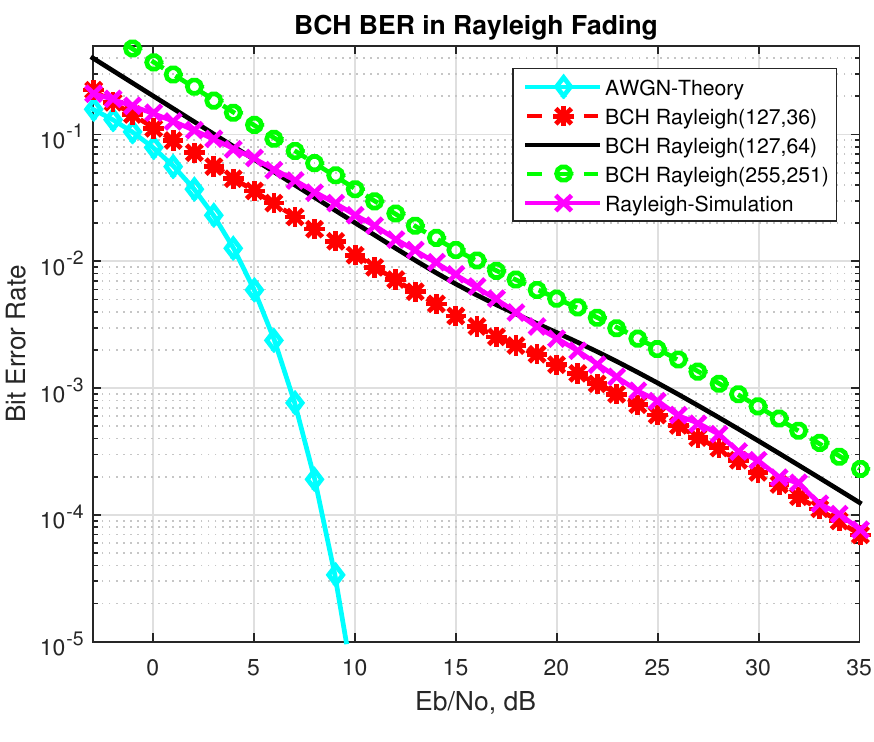
Figure 5. BER of BCH in Rayleigh fading.